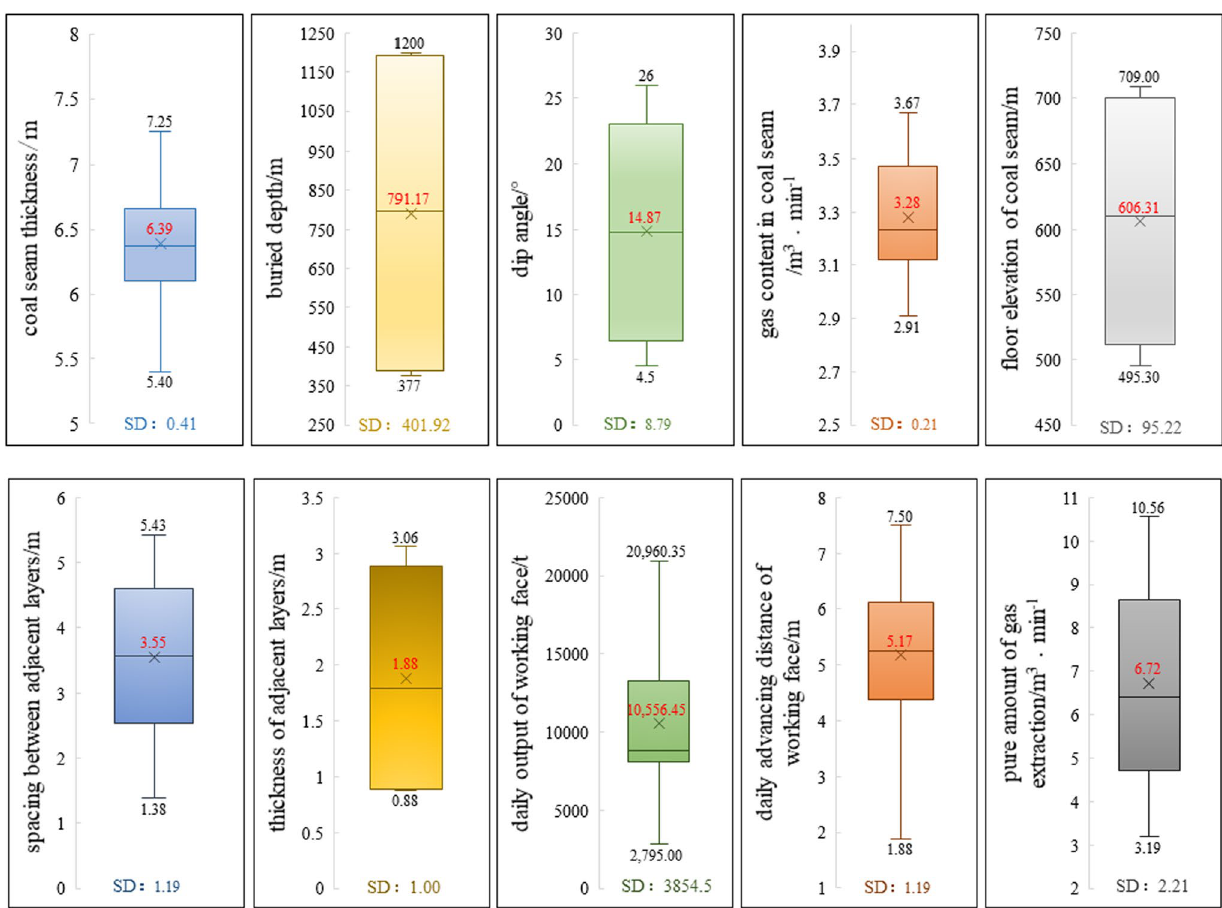
Fig. 1 Box plot of various gas emission parameters. Notes : The upper and lower data represent the maximum and minimum values of each parameter, respectively, and the red data represent the average